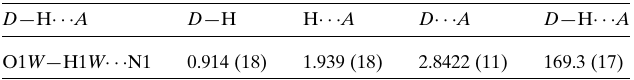
Table 1 Hydrogen-bond geometry (A˚ , (cid:3) ).